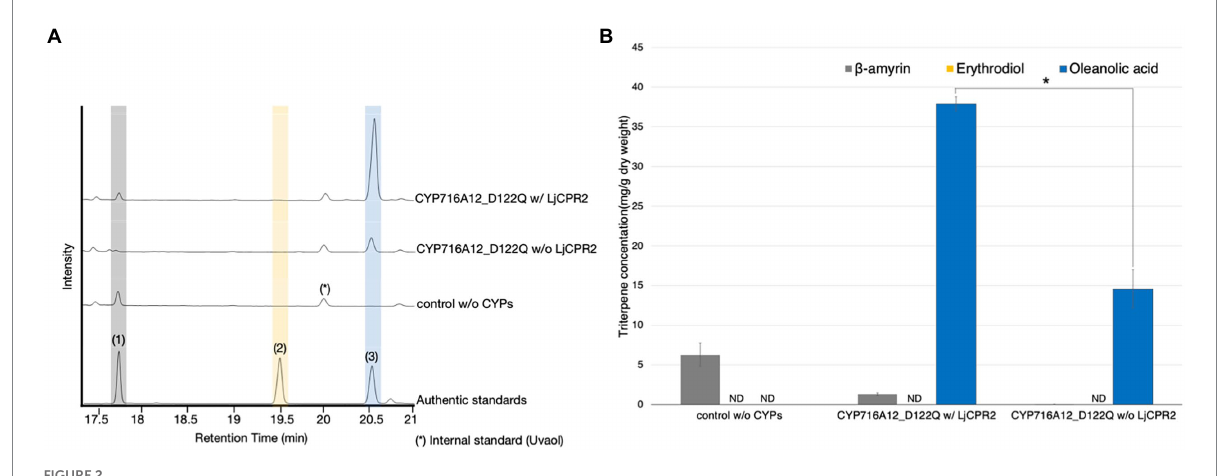
FIGURE 2 Requirement of additional CPR to optimize the CYP microenvironment for enhancement of oleanolic acid production in Nicotiana benthamiana. (A) TICs of extracts from N . benthamiana leaves transiently expressing a combination of LjOSC, CYP716A12_D122Q with or without LjCPR2 using pBYR2HS. A combination of LjOSC, LjCPR2, and empty vector was used as a background control. β -Amyrin ( 1 ), erythrodiol ( 2 ), and oleanolic acid ( 3 ) were used as authentic standards. Uvaol (*) was used as an internal standard. (B) Quantification of triterpene concentration in N . benthamiana leaf extracts. Data are representative of at least three biological replicates ( n = 3) and are expressed as the mean ± SEM. Differences in oleanolic acid production were examined using Student’s t -test for each sample. * p < 0.05; ND, not